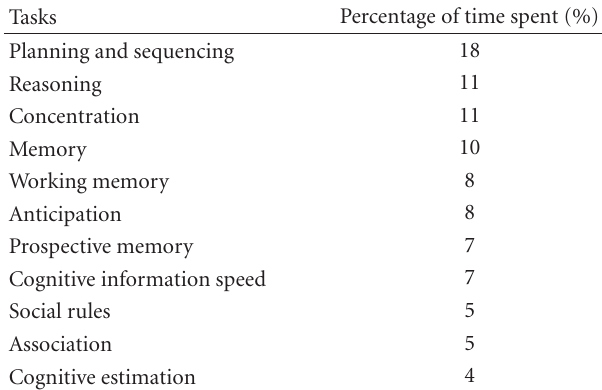
Table 5: Transfer training: time spent on di ff erent tasks. Tasks Percentage of time spent